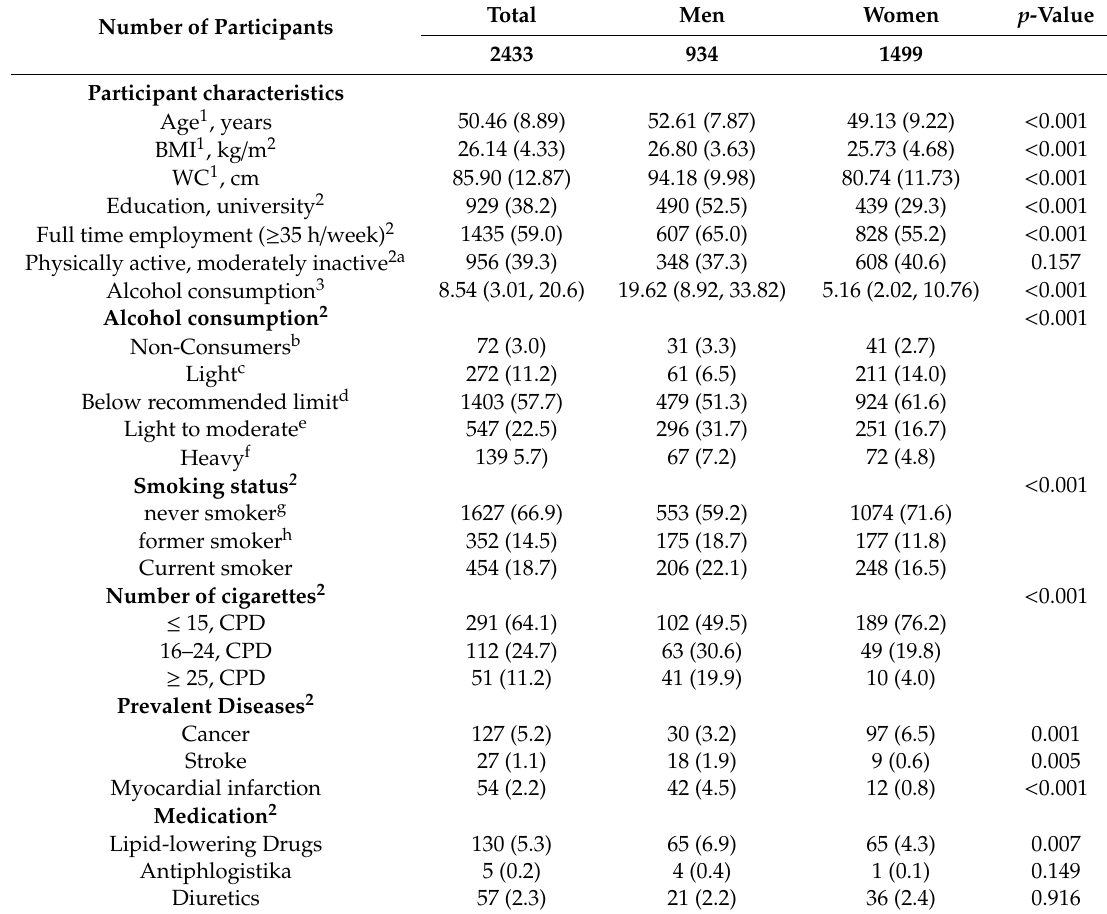
Table 1. Characteristics of the study population at the time of recruitment (1994–1998) in EPIC-Potsdam by